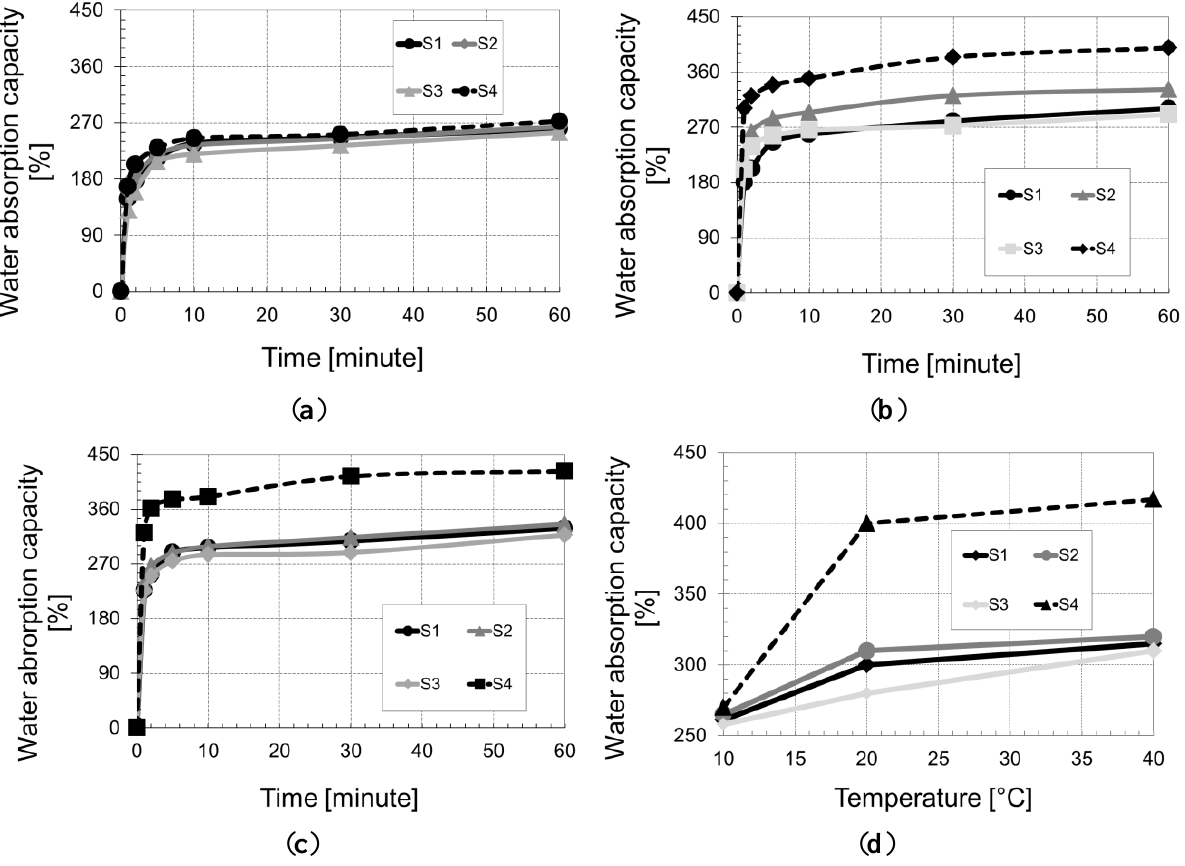
Figure 5. Water absorption capacity vs . time at different temperatures ( a ) at 10 °C; ( b ) at 20 °C; ( c ) at 40 °C; ( d ) water absorption capacity vs .